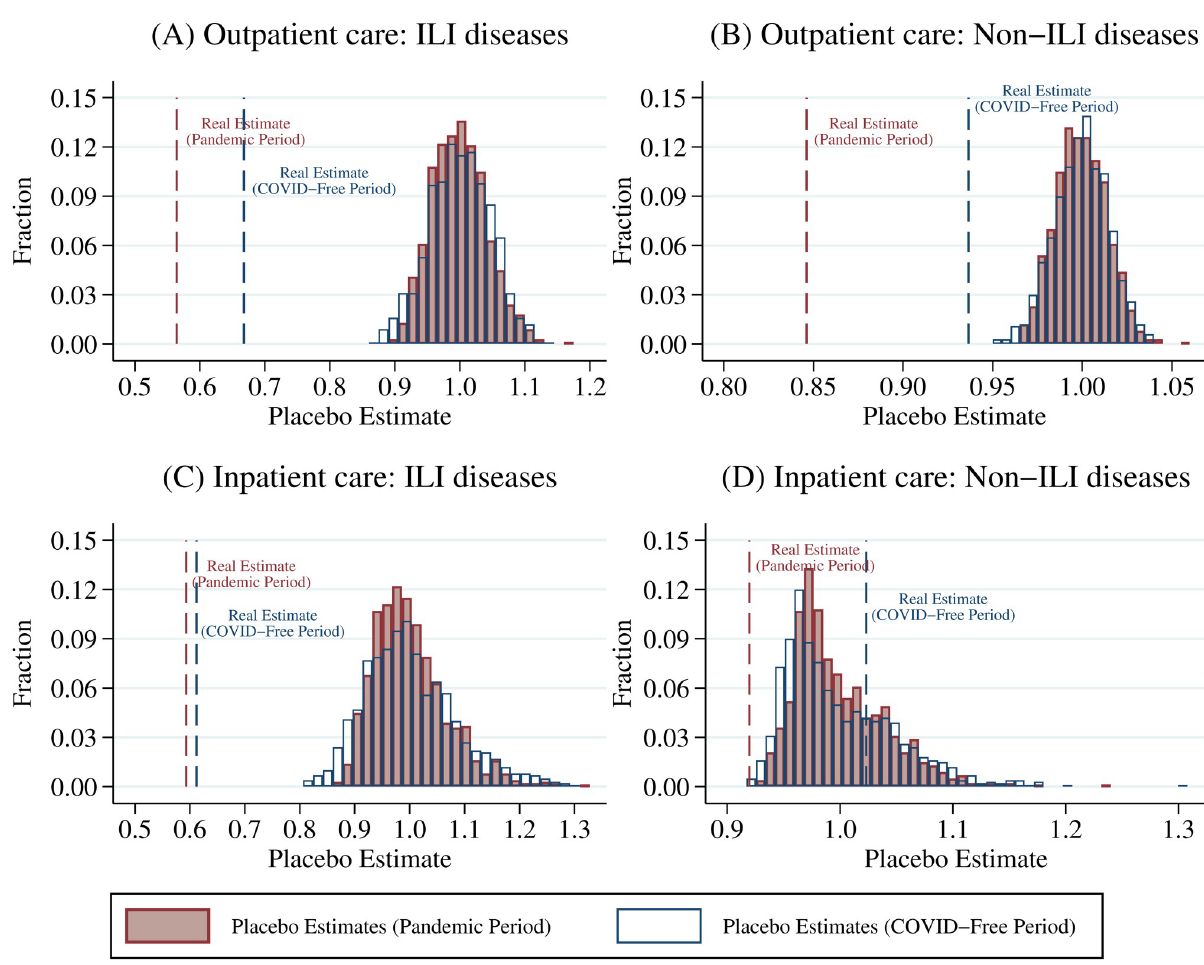
Fig 5. Placebo test: Multi-period DID design. A: Outpatient care: ILI diseases. B: Outpatient care: Non-ILI diseases. C: Inpatient care: ILI diseases. D: Inpatient care: Non-ILI diseases. We use the 2014–2019 sample and randomly select one year as the pseudo “treated year” in each county and estimate Eq (2). We repeat the above procedures 1,000 times to obtain the distribution of placebo estimates. This figure compares our real estimate with these placebo estimates. The vertical axis displays the relative frequency of the estimates. The red (blue) dashed line denotes the real estimates for COVID-19 effects during the pandemic period (COVID-free period). The red (blue) bars denote the placebo estimates for COVID-19 effects during the pandemic period (COVID-free period).